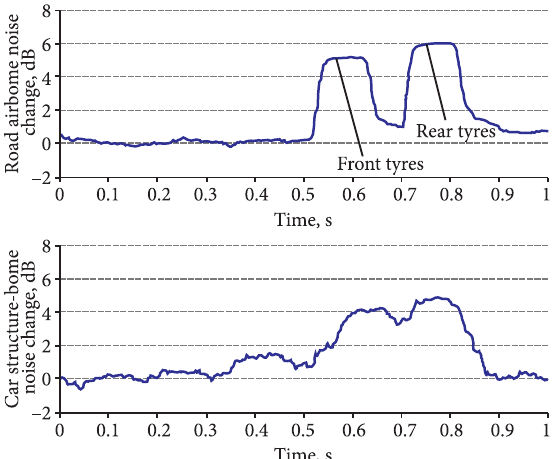
Fig. 9. The raw data captured by Direct Sound and Vibration Measurement Methodology on Bridge A (Joint A2)